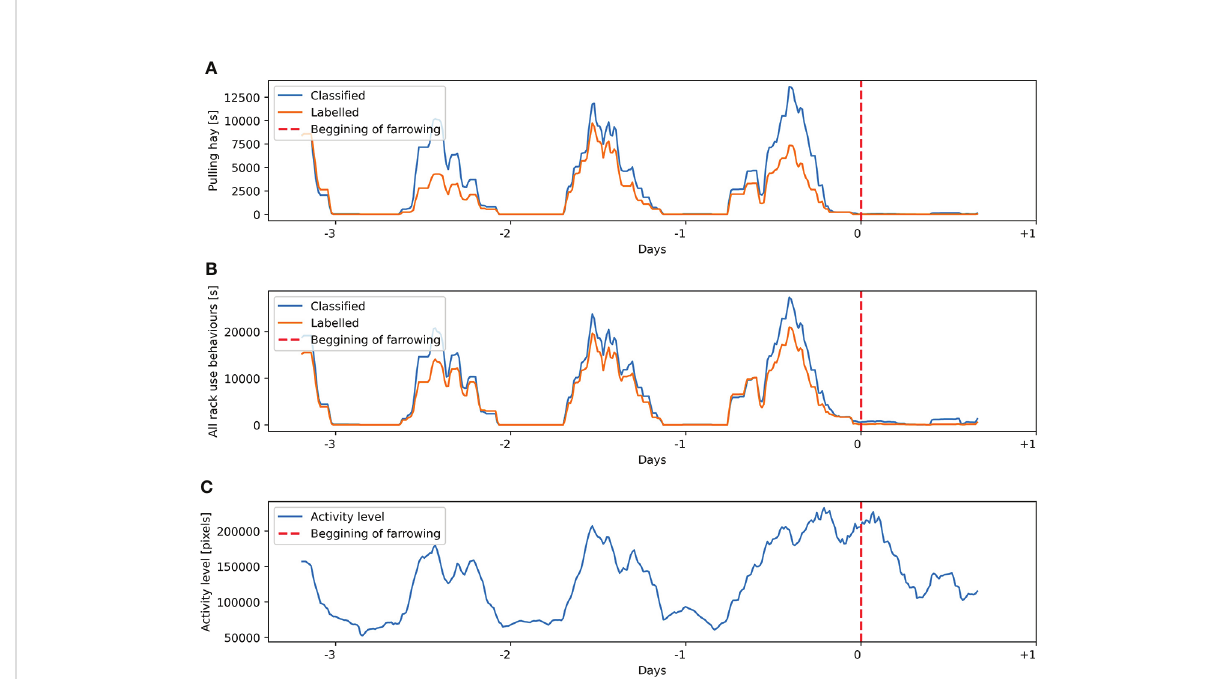
FIGURE 10 Labeling and classi fi cation for sow 12 from the validation dataset of (A) pulling hay behavior and (B) all hay rack use behaviors. (C) Activity level estimated on the basis of the Euclidean distance between the centroids of the sow ’ s body in consecutive frames. Presented variables are calculated on a sliding window of 4 h with 15 min